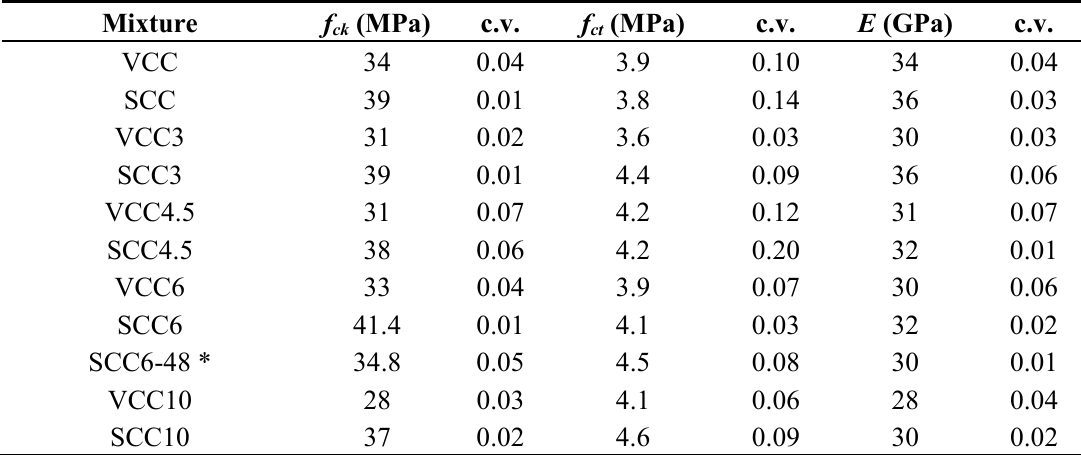
Figure 7. Splitting tensile strength. Table 2. Mechanical properties of the polyolefin fiber-reinforced concrete